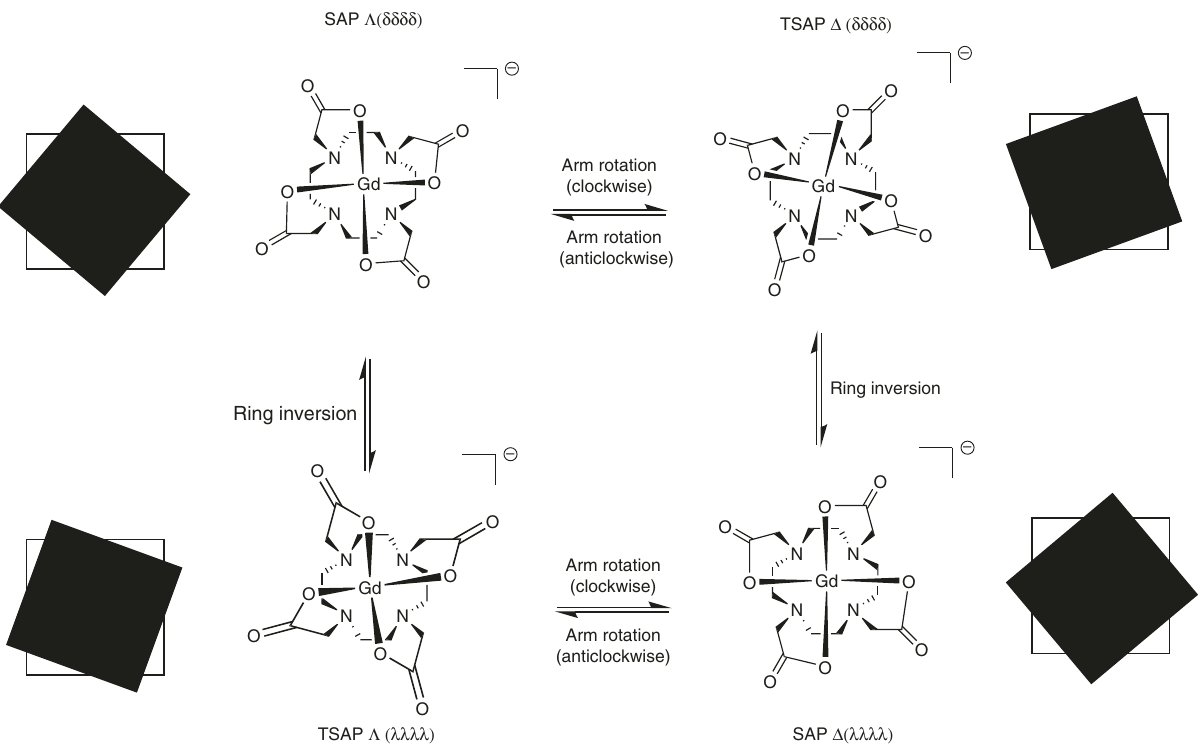
Fig. 2 Illustration of the solution behaviour of Gd 3 + complexes of H 4 dota. H 4 dota is an important cyclic ligand ubiquitous in clinical settings. There are four possible stereoisomers for [Gd(dota)] − and interconversion between them is shown. The geometry can be visualised if the donor atoms are considered in planes, with the macrocyclic N4 donors forming one plane (white square), and the acetate O4 donors another (black square). Pairs of enantiomers are diagonally opposite one another. Individual atom charges and coordinated water molecules are omitted for clarity. (Adapted with permission from ref. 55